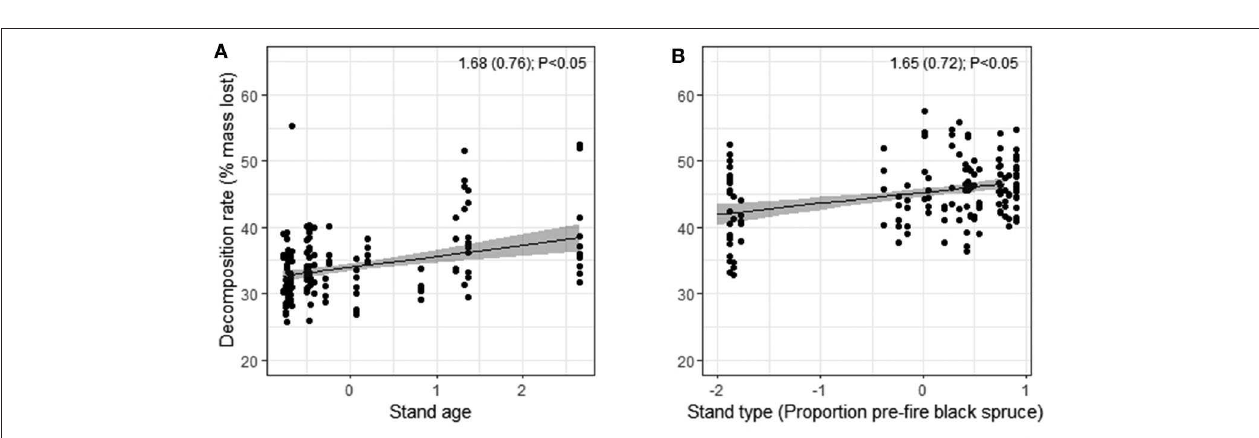
FIGURE 5 | Model-based predictions of in situ decomposition rates of litter of (A) black spruce against stand age, and (B) birch against pre-fire stand type (proportion pre-fire black spruce stems) based on percent mass lost in litterbags over 24 mos. at 30 plots in burned boreal forests, Northwest Territories, Canada. The y-axes show predicted values from linear mixed effects models, with standardized predictors on the x-axes. Estimated coefficients, standard errors, and P -values are shown. Full model summaries are reported in Table S9